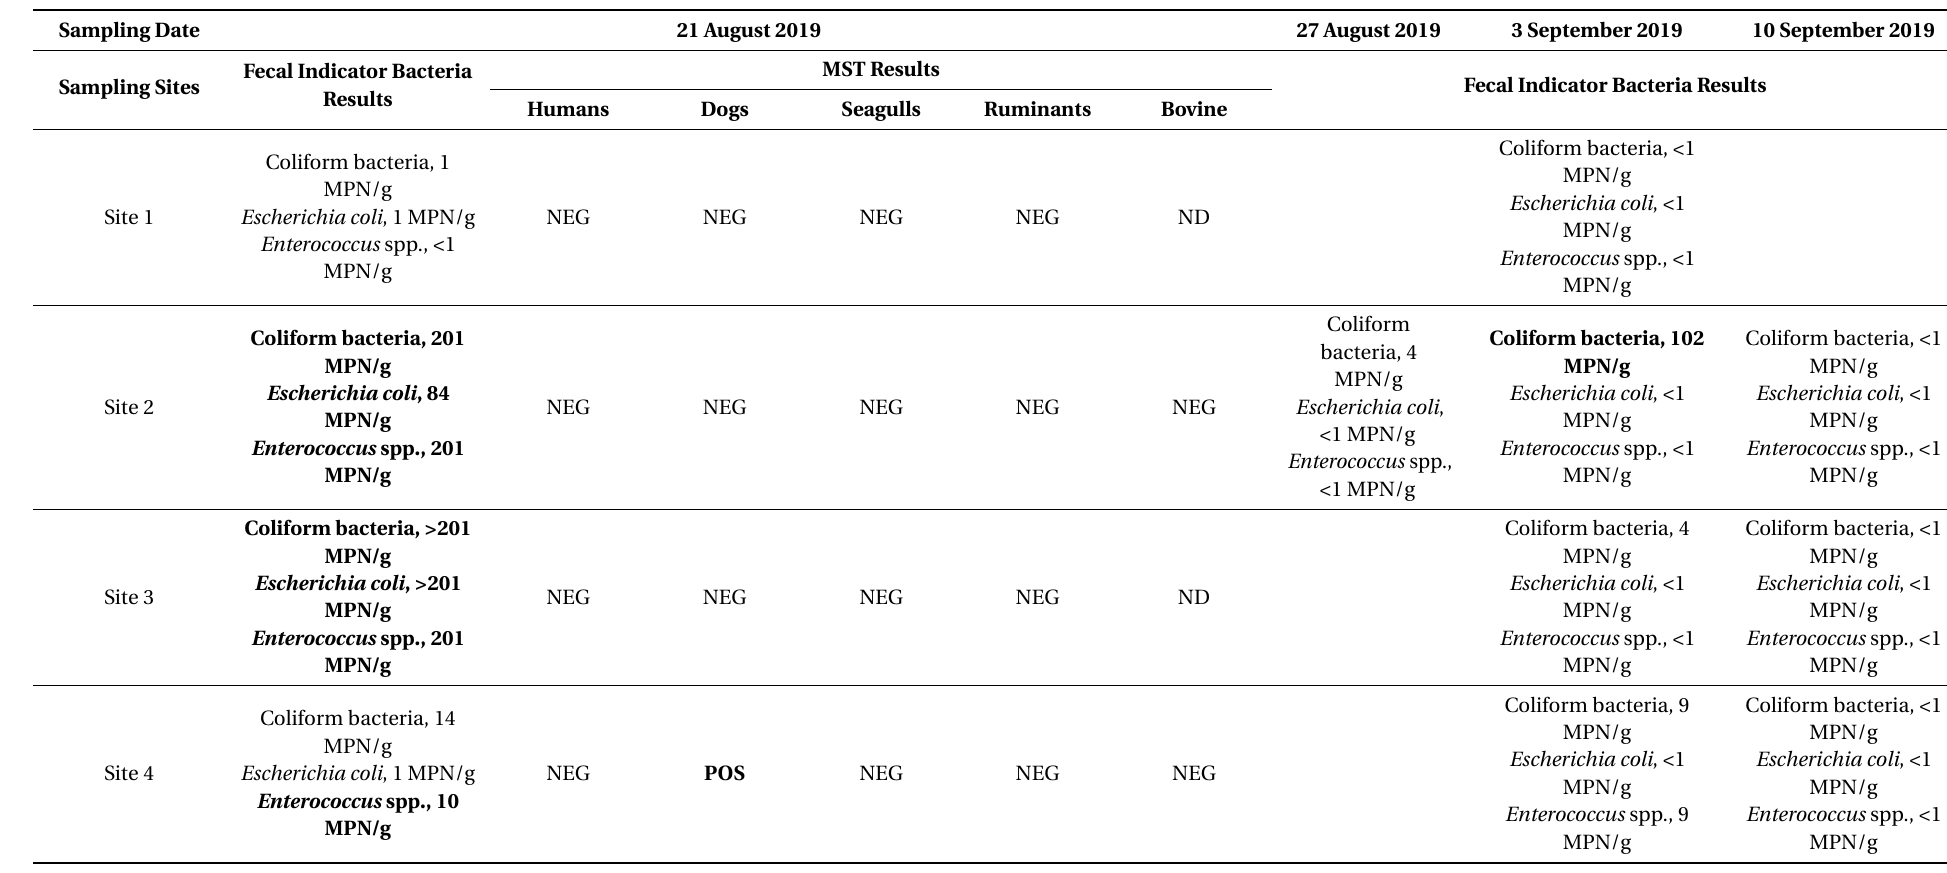
Table 2. Results of the microbiological tests and microbial source tracking (MST) of the sand samples collected on several dates throughout this